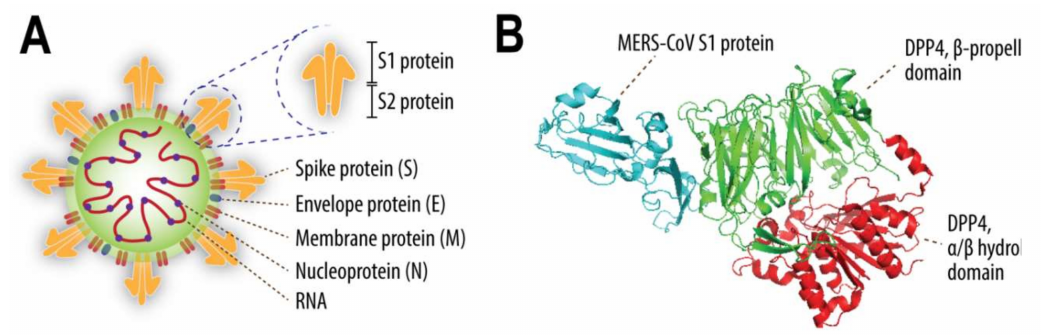
Figure 1. Schematic figure depicting four structural proteins of Middle East respiratory syndrome coronavirus (MERS-CoV), i.e., S, E, M, and N proteins ( A ); a cartoon representation of MERS-CoV S1 protein binding to DPP4 (PDB code 4L72) ( B ). The S protein consists of the S1 and S2 subunits. The α / β hydrolase domain of DPP4 is indicated in red, β -propeller domain in green, while part of the MERS-CoV S1 protein is shown in